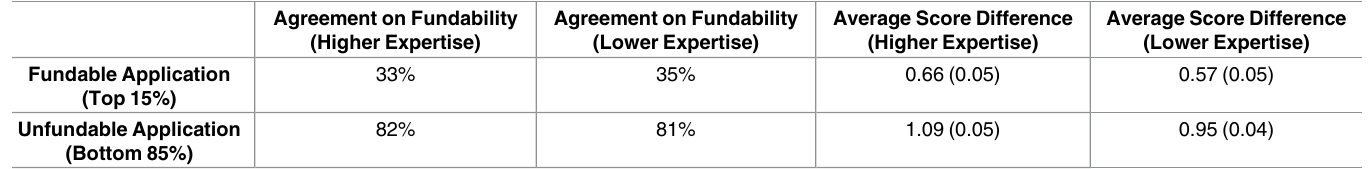
Table 5. Reviewer scoring and fundability